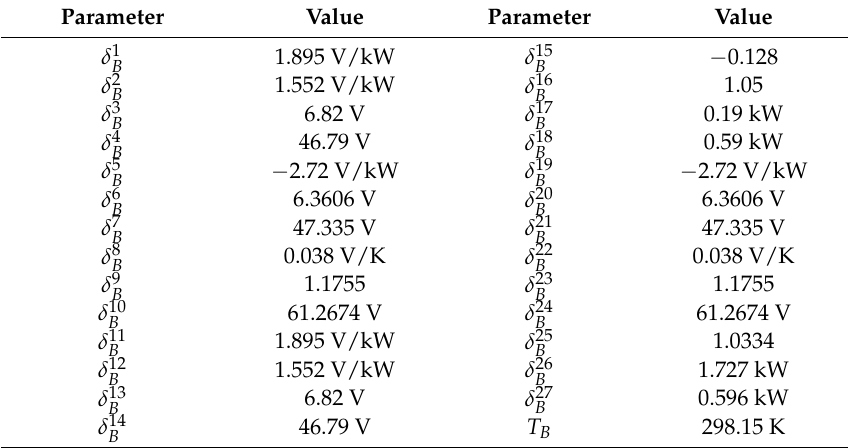
Table 1. Parameters of VRB model